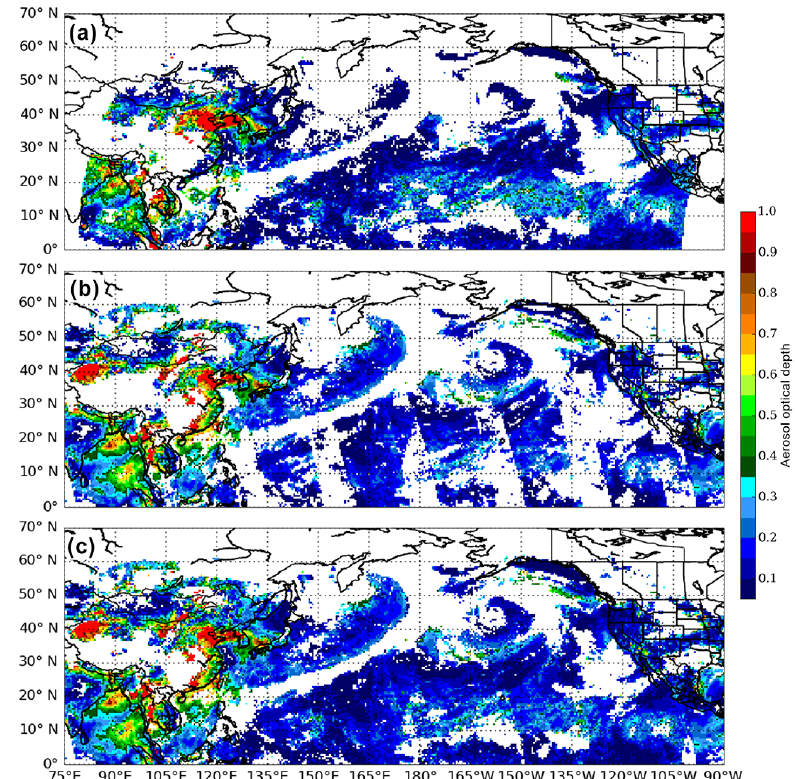
Figure 6. Panels show the daily AOD composites with central time at 00:00UTC on 23 March 2014. (a) Example of the daily AOD composite when only GEO retrievals are utilized, (b) example of when only LEO retrievals are utilized, (c) final version of our daily AOD composite product.